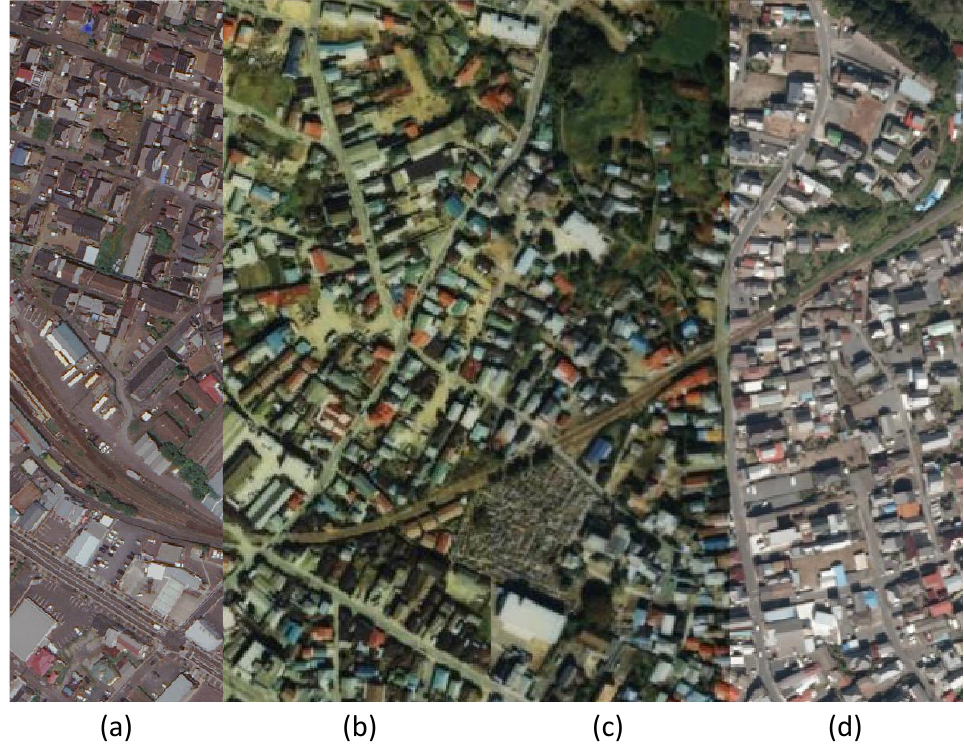
Figure 18. Mosaic of reference and registered images: ( a ) WV-3 (reference image), ( b ) old-period aerial photo 1, ( c ) old-period aerial photo 2 and ( d ) new-period aerial photo.